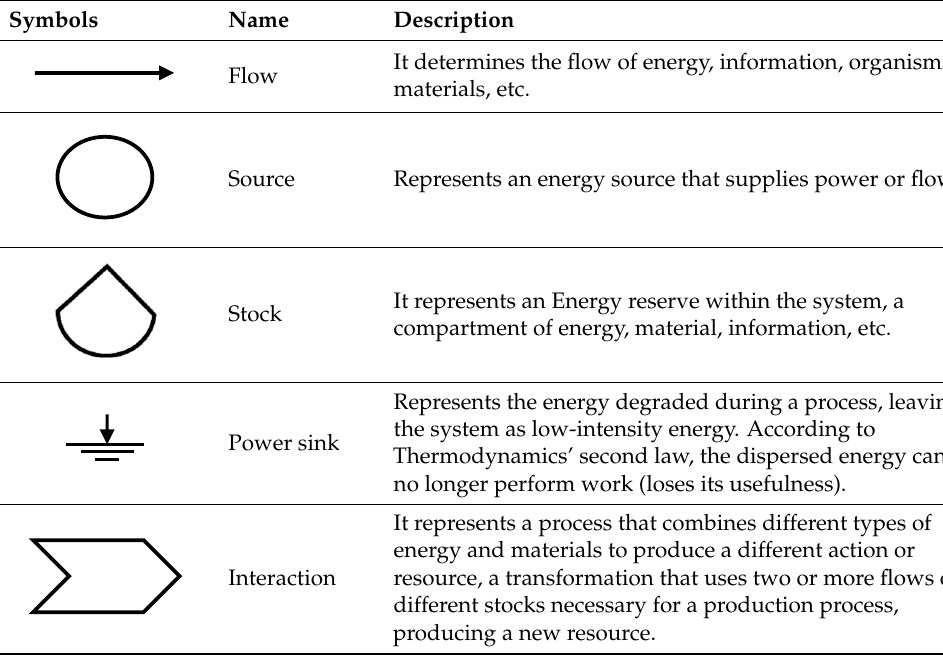
Table 2. Emergy indices need to be calculated for the agricultural production system, according to Odum (1996).